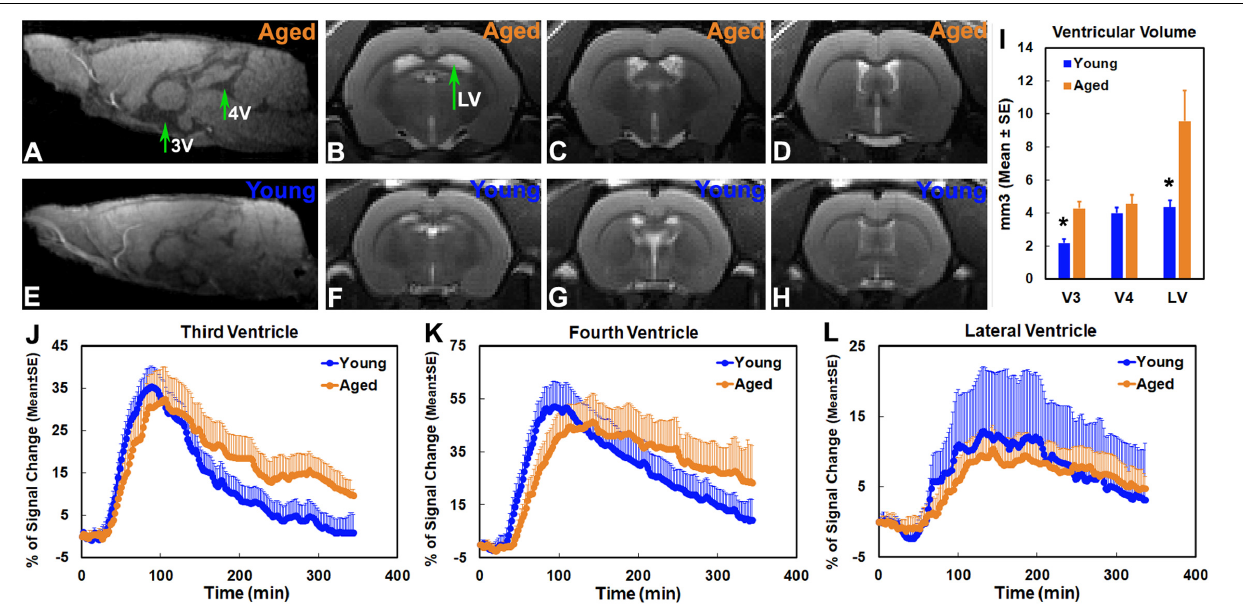
FIGURE 5 | Sagittal section ( A,E , Lateral − 0.10 mm) at the level of the third (3V) and fourth (4V) ventricles, coronal sections ( B–D,F–H , Bregma − 1.72 mm, − 0.72 mm, 0.24 mm) at the representative structural locations containing the lateral ventricles (LV), ventricular volumes (I) and group TSCs (J–L) obtained from the corresponding ventricles. Ventricular enlargement was present in the aged brain (A–D vs. E–H) . Significantly expanded third and lateral ventricles were detected in the aged brain as compared to the young brain ( I , * p < 0.03, Young vs. Aged in the same ventricle). Compared to the young brain, a reduced pace for contrast movement through the third (J) and fourth (K) ventricles was detected in the aged brain. In addition to the decreased maximum levels of TSCs (J,K) , prolonged periods of time were taken in the aged brain to attain the peak values of TSCs and to attenuate the signal intensities afterward (J,K) . Nevertheless, reduced differences in group TSCs between young and aged brain were found in lateral ventricles (L)